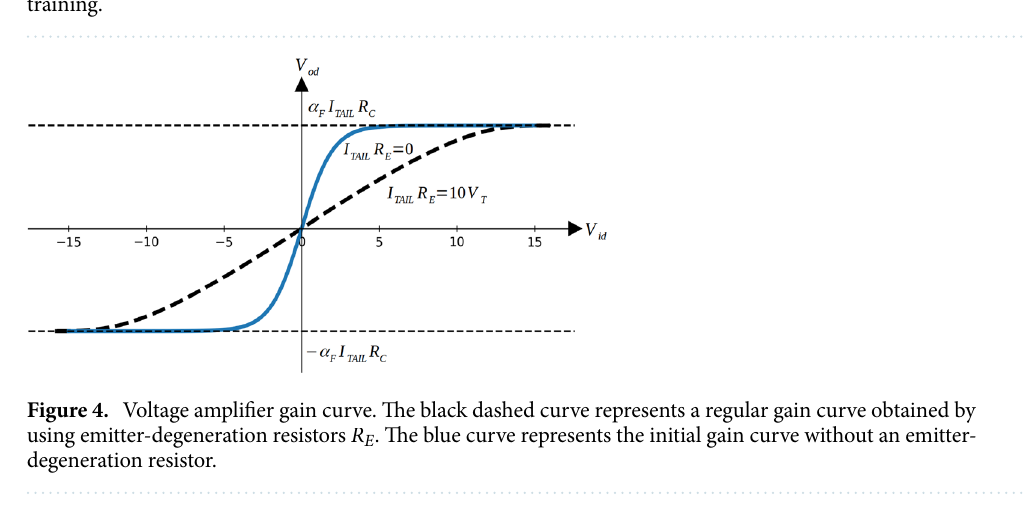
Figure 3. Performance comparison for the 3-bit delayed XOR task, for electrical ( a ) and optical ( b , c ) readouts. In ( b ), the readout is trained by linear regression and in ( c ) backpropagation through the photodetector is performed. It is clear that for this last option the actual output of the system (orange) most closely resembles the target (blue). ( d ) Evolution of Bit Error Rate and Normalised Mean Square Error during the backpropagation training.